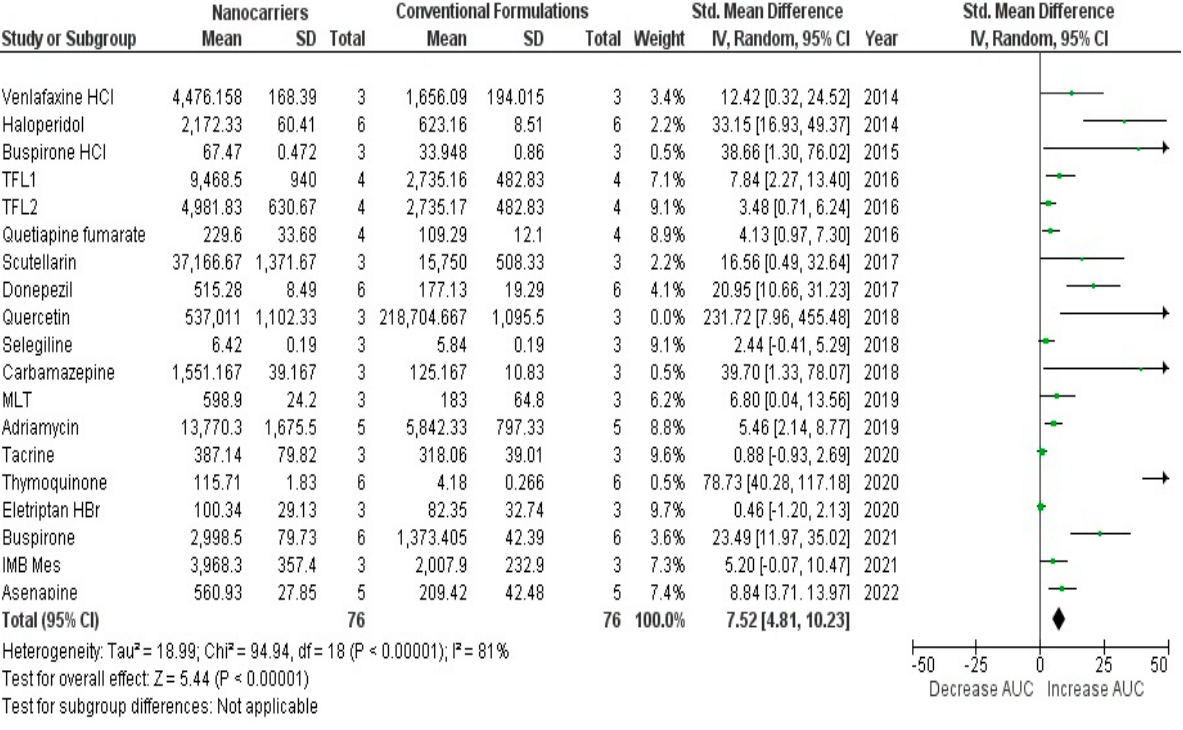
Figure 3. Forest plot presenting meta-analysis of investigated studies [26–44] generated using Review Manager v.5.4.1. ®